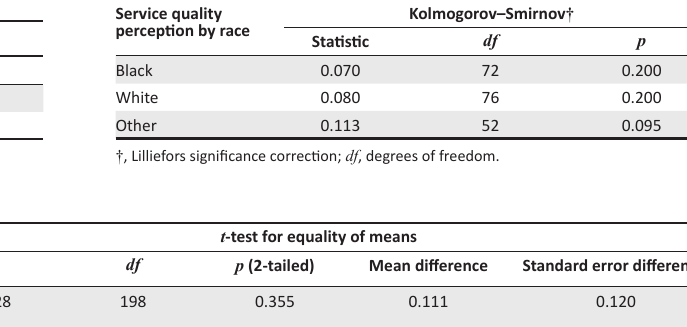
TABLE 9: Test of normality of distribution of responses (service quality perception and